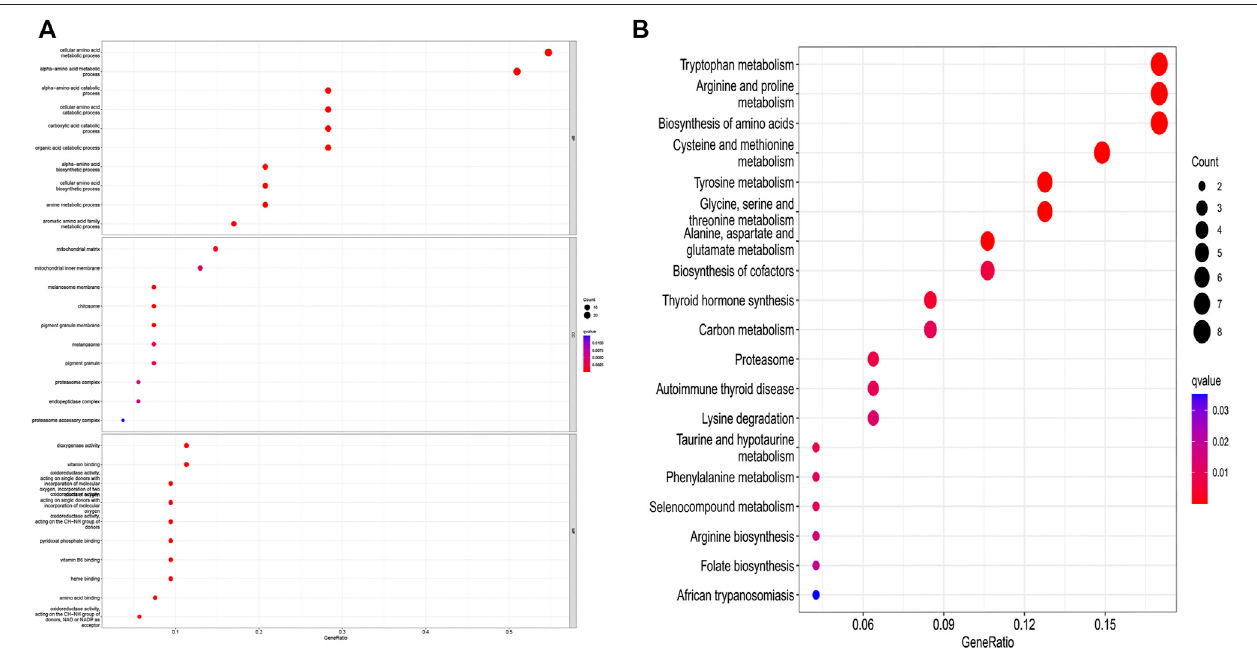
FIGURE 2 | GO and KEGG analysis of amino acid metabolism-associated DEGs. (A) GO and (B) KEGG.